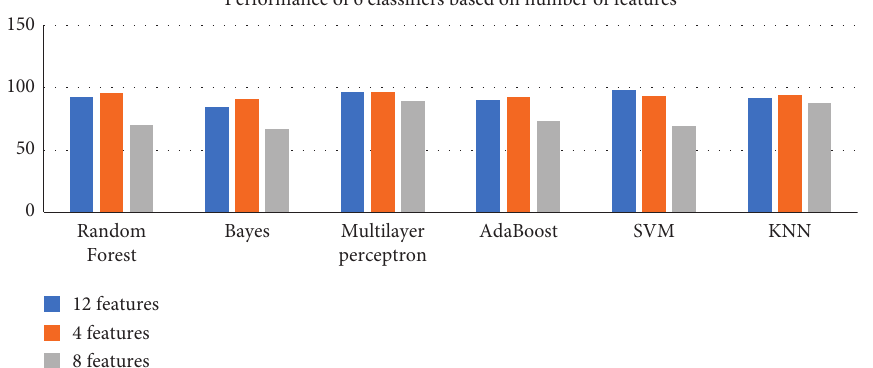
Figure 15: Performance of 6